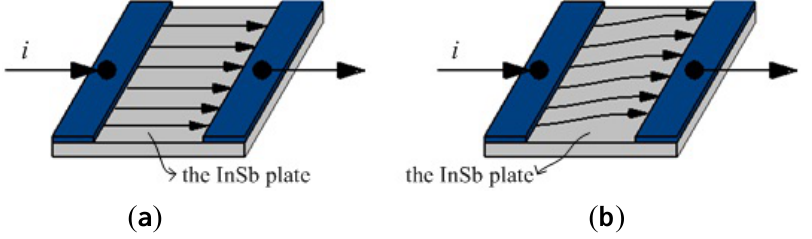
Figure 2. The model of magnetoresistive effect. ( a ) Current mode under non-magnetic field; ( b ) Current mode under magnetic